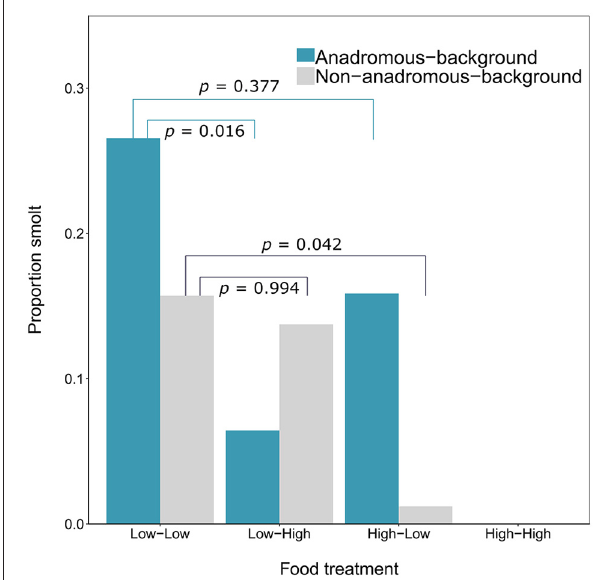
FIGURE 1 | Proportion of brown trout ( n = 567, F1 offspring of wild trout from two population backgrounds) classed as smolts after 2 years of tank rearing under varying food restriction treatments. Food treatment is denoted in the format “food in year one—food in year two,” where “high” refers to optimal food rations and “low” refers to 25% of optimal rations. P -values shown are Tukey post-hoc pairwise comparisons across all levels of food treatment for each